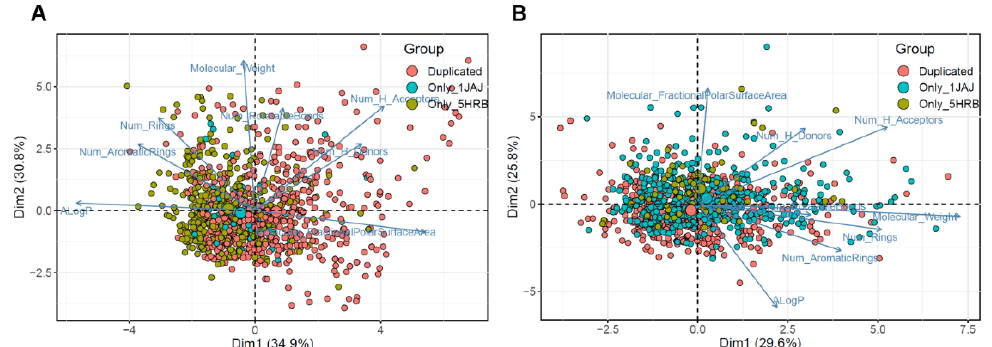
Figure 3. Visual representation of the chemical space of 1JAJ and 5HRB datasets. Distribution of the chemical space of the compounds in the 1JAJ and 5HRB datasets, according to principal component analysis. ( A ) Compounds with ≤− 4.0 kcal/mol binding free energies. ( B ) Compounds with ≥− 4.0 kcal/mol binding free energies. The loading plot vectors are represented by arrows for each physicochemical